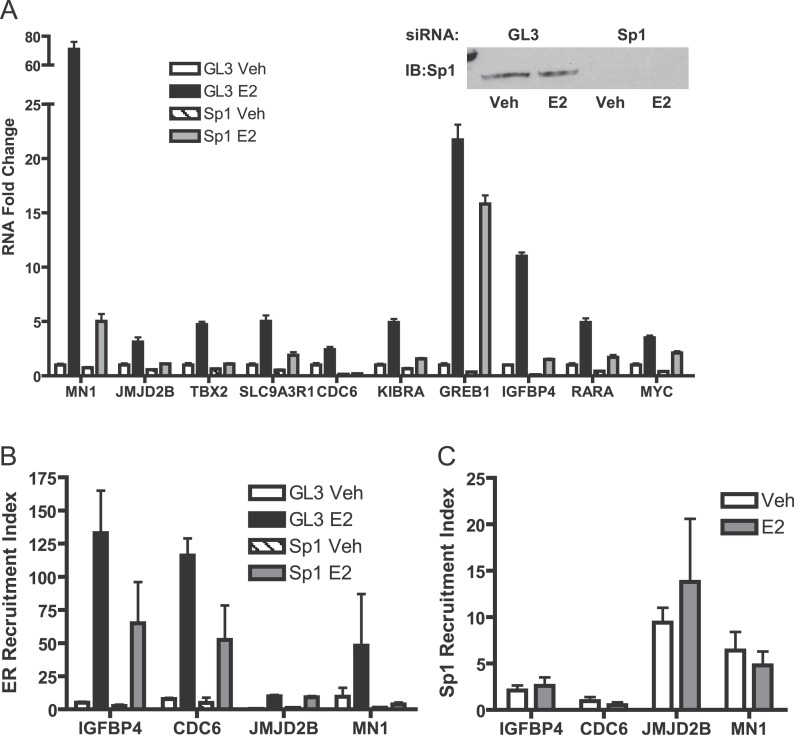
Impact of Sp1 Knock-Down in MCF-7 Cells on E2 Stimulation of Target Genes Adjacent to ChIP-PET Clusters with Predicted Sp1 Binding Sites(A) Cells were transfected with GL3 luciferase siRNA control or Sp1 siRNA constructs 72 h prior to treatment with 0.1% ethanol vehicle or 1nM E2 for 4 h. Expression of target genes was analyzed by quantitative real-time PCR. Values and error bars are based on the mean of three determinations.(B) Knock-down of Sp1 impacts ERα recruitment to E2-regulated genes. ChIP assays using ERα antibody were performed after transfection of MCF-7 cells with GL3 luciferase siRNA control or Sp1 siRNA for 72 h followed by 45 min treatment with 0.1% ethanol vehicle or 1nM E2.(C) Sp1 is present at ChIP-PET regions of E2-target genes, but its presence is not affected by E2 treatment. ChIP assays were performed using Sp1 antibodies after 45 min of 0.1% ethanol vehicle or 1nM E2 treatment. Enrichment of ERα or Sp1 at ChIP-PET regions was evaluated by quantitative real-time PCR and normalized to IgG control antibody. Results average two to four independent determinations.